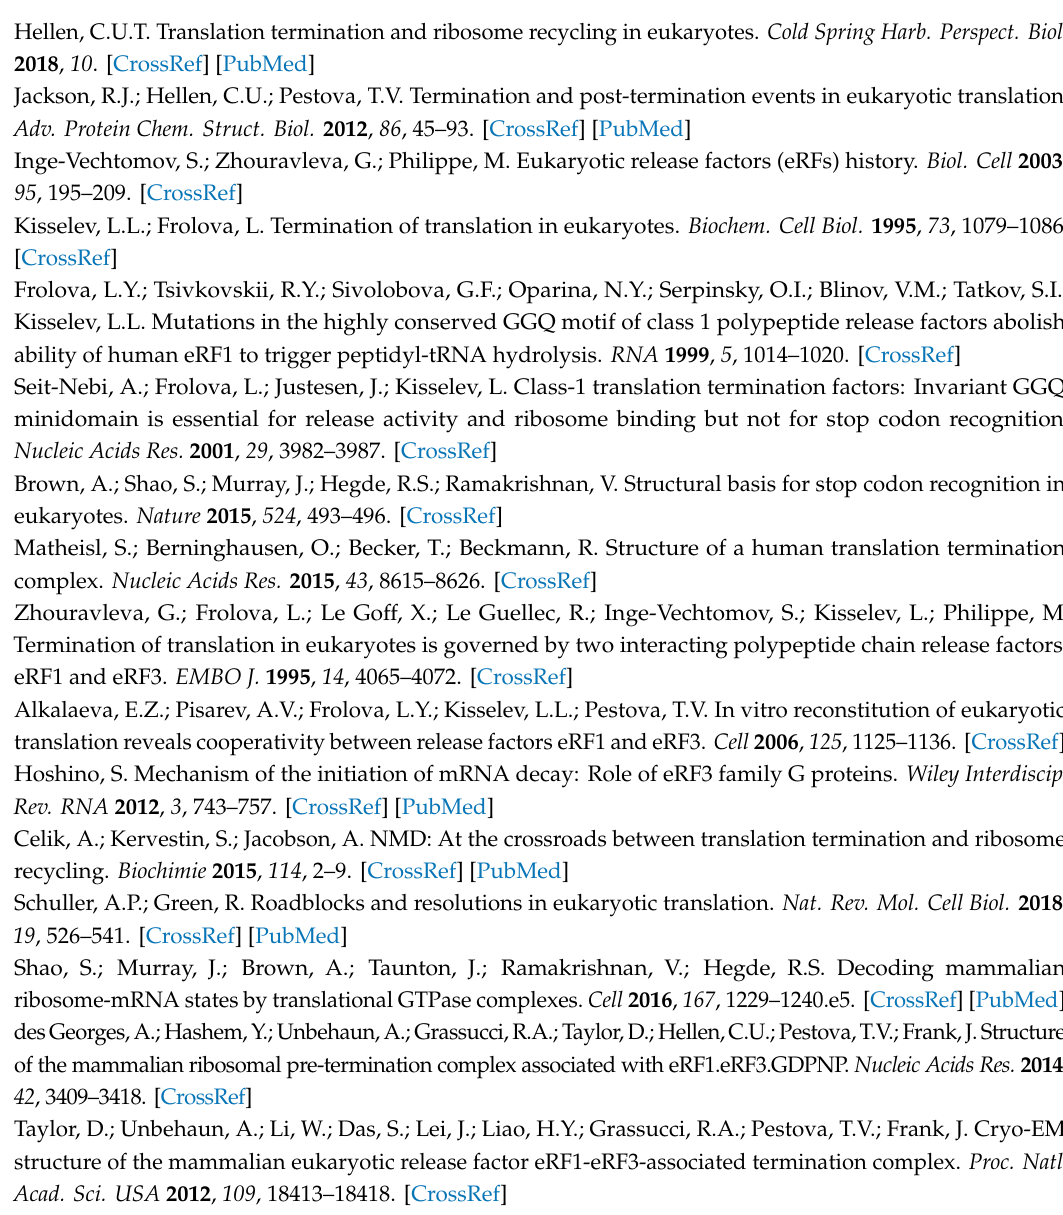
Figure S1: Time-course of luciferase activity accumulation in a cell-free translation reaction programmed by capped FLUC and CTELS2 transcripts. Figure S2: E ff ects of recombinant eRF1 (wt and AGQ mutant) on accumulation of luciferase activity in in vitro translation reactions programmed by di ff erent reporter mRNAs. Table S1: Plasmids used in this study [83]. Table S2: Primers used in this